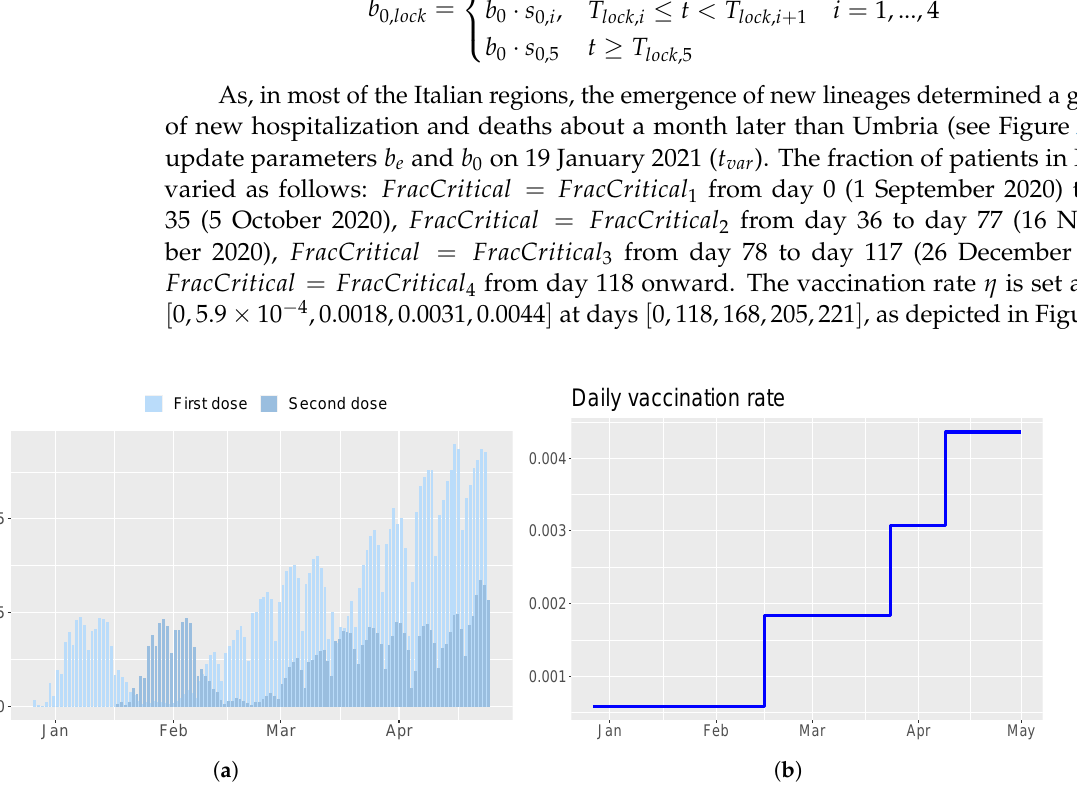
Figure 9. Vaccination campaign in Italy. ( a ) Number of first (light blue) and second (blue) doses injected every day. ( b ) Profile of the evolution of the vaccination rate η chosen for model